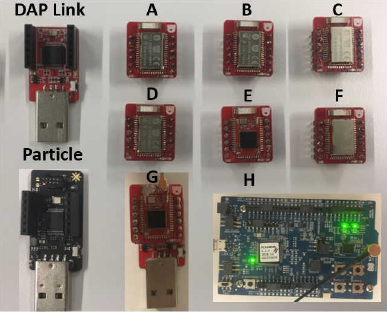
Figure 1: Several instances of the device under